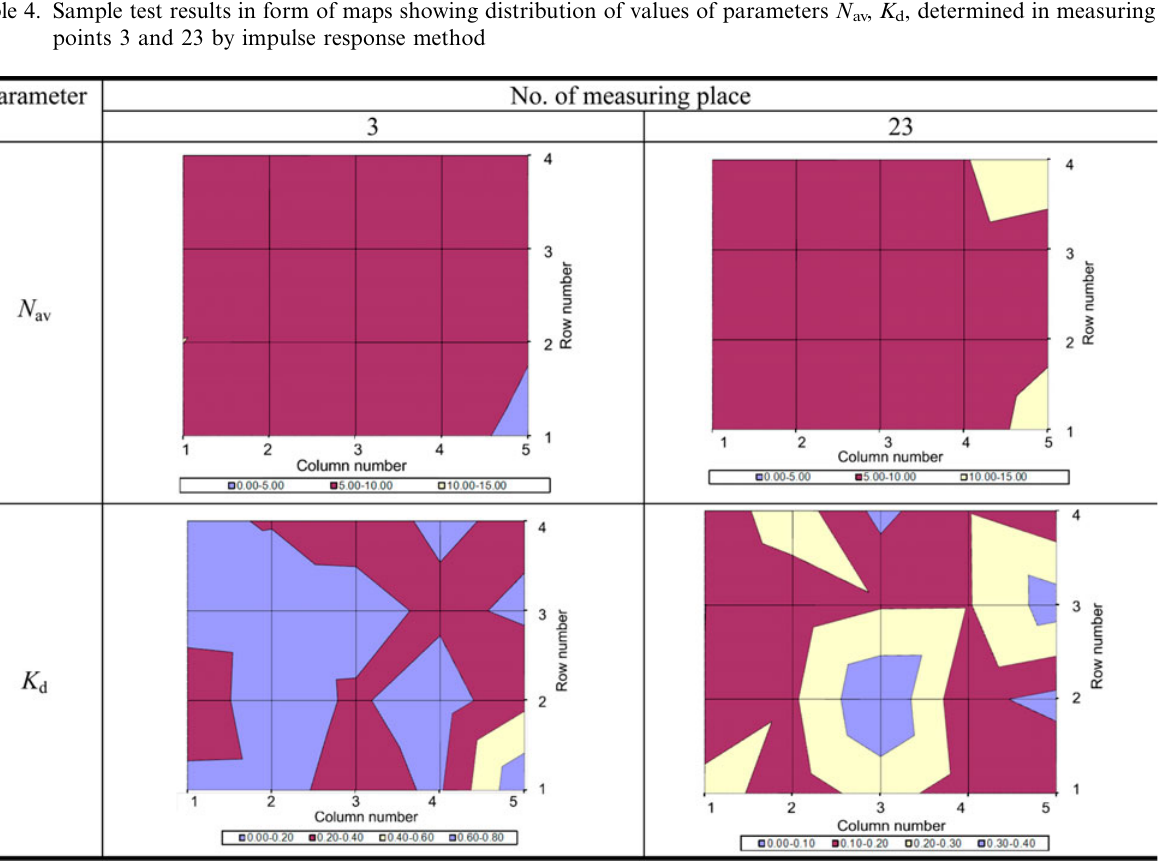
along the entire length of the wall) was marked in each measuring place. The distance between the measuring points amounted to about 500 mm.